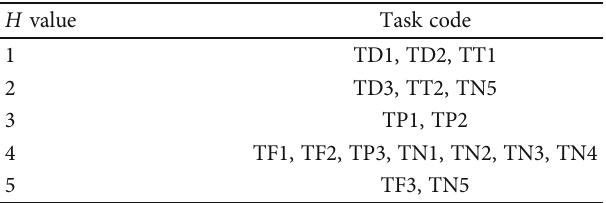
Table 3: H value of each task in Figure 6. H